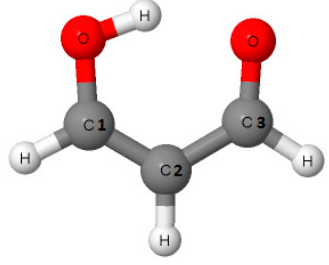
Scheme 1. Malonaldehyde—an example of the resonance assisted hydrogen bond (RAHB) system; the numeration of C-atoms—1, 2, 3—is applied later in Tables to show the position of substituents in